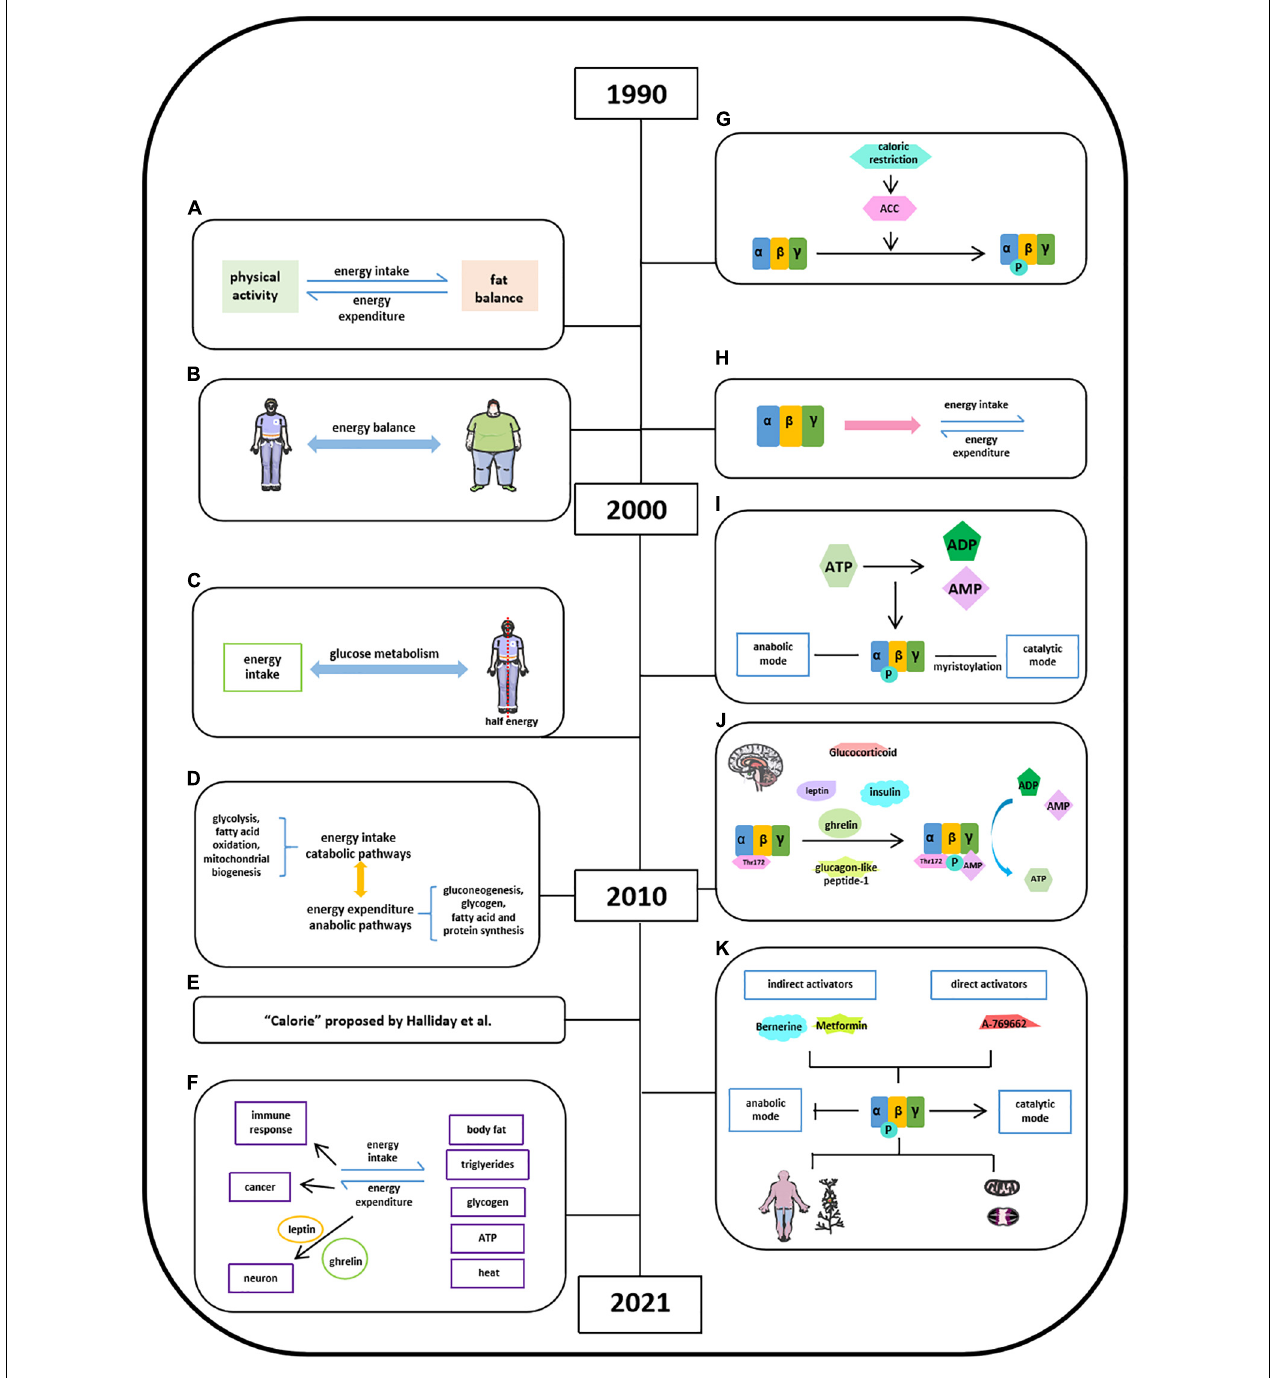
FIGURE 2 | Milestones of discoveries of energy balance and the role of AMPK in energy balance. (A) Concept of energy balance. (B) Well-balanced energy is critical in maintaining a stable body weight. (C) Half of the body energy was obtained from glucose metabolism after energy intake. (D) Concept of energy intake (catabolic pathways) and energy expenditure (anabolic pathways). (E) The quantification of energy was measured by the unit “calorie” proposed by Halliday et al. (2011). (F) Format of energy store and energy balance involved activities. (G) AMPK is activated via inducing ACC by calorie restriction. (H) AMPK protein structure has been studied in energy balance. (I) , Energy imbalance between anabolic and catabolic process in some metabolic syndromes is due to ATP consumption. (J) Factors reported to stimulate AMPK activation in hypothalamus. (K) AMPK may act as the key regulator in energy balance in a specific organ or tissue.